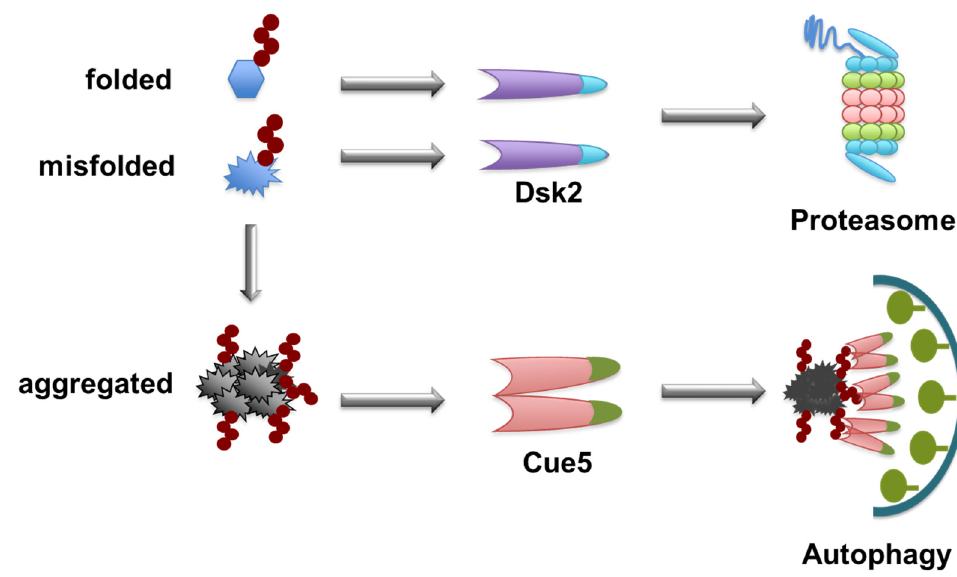
Figure 3. Proteasome receptor Dsk2 and autophagy receptor Cue5 function in the clearance of soluble and aggregated substrates. Monomeric Dsk2 binds soluble or slightly misfolded substrates modified with ubiquitin chains for proteasome degradation. When overwhelming numbers of misfolded proteins accumulate into stable aggregates, oligomeric Cue5 then binds to and targets substrates for autophagy